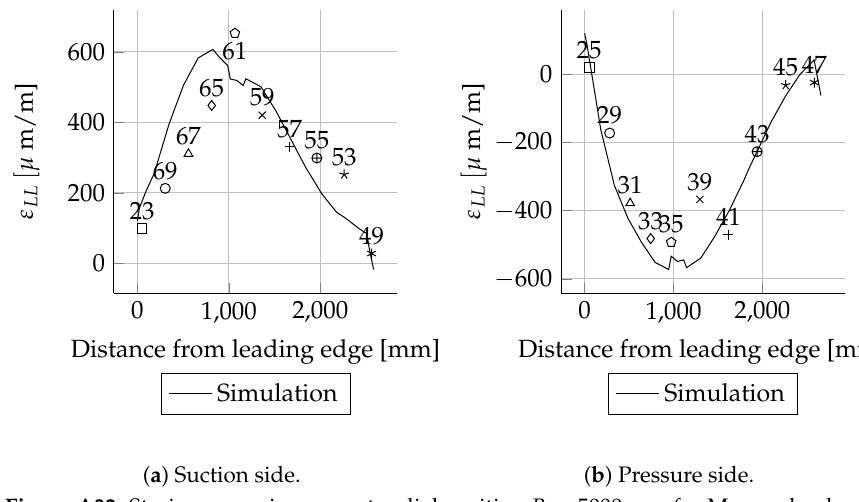
Figure A32. Strain comparison ε TT at radial position R = 5000 mm for Mymax load